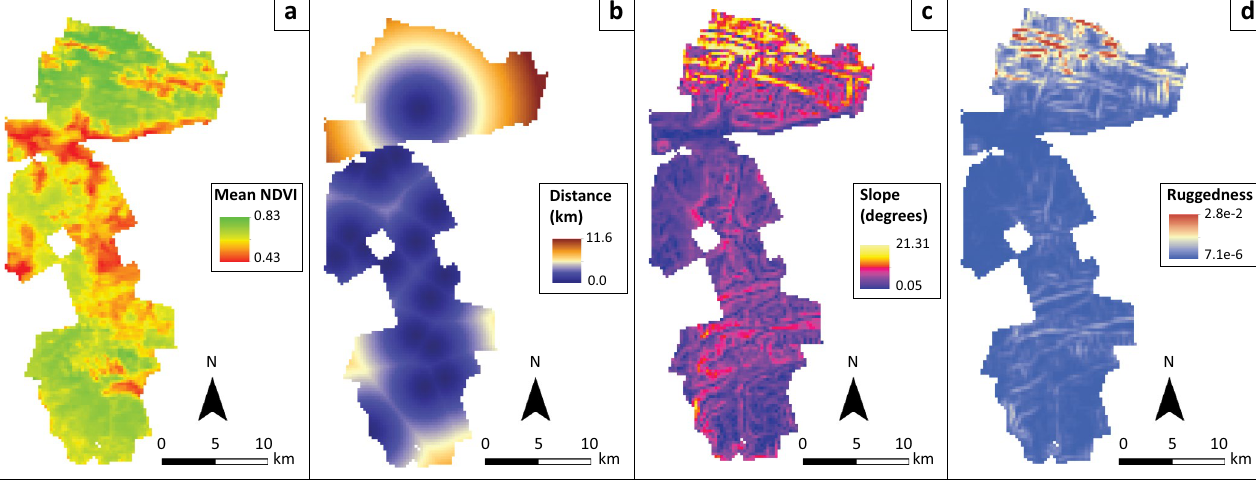
Note that Normalised Difference Vegetation Index in the models was included as time-specific Normalised Difference Vegetation Index values obtained from 70 sixteen-day Moderate Resolution Imaging Spectroradiometer composites (see the main text for details). However, the mean Normalised Difference Vegetation Index across the study period (06 March 2010 – 21 March 2013) is displayed here for visualisation period to allow comparison of general trends in Normalised Difference Vegetation Index values over space. FIGURE 2-A1: Covariate data used as inputs into step selection function models for resource selection by female elephants in Addo Elephant National Park, South Africa. Covariates modelled included (a) Normalised Difference Vegetation Index, (b) distance to artificial water, (c) slope and (d) terrain ruggedness.